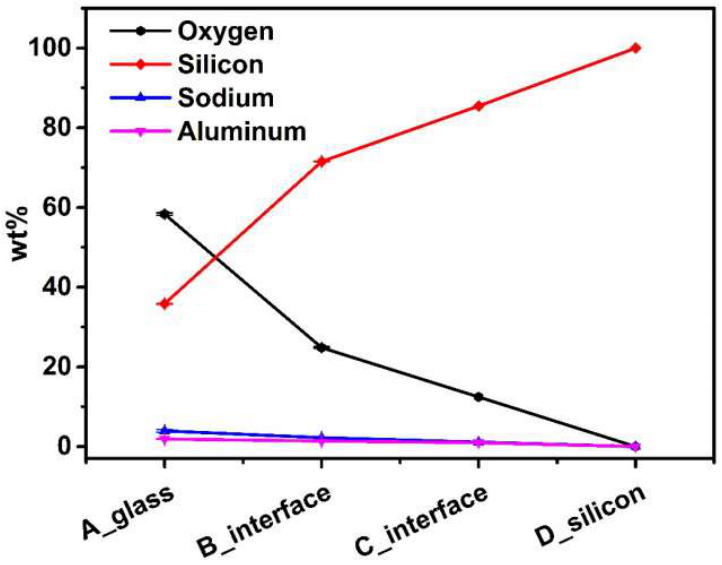
Figure 5. The chemical composition contained in the four test regions in weight percentage (wt%).